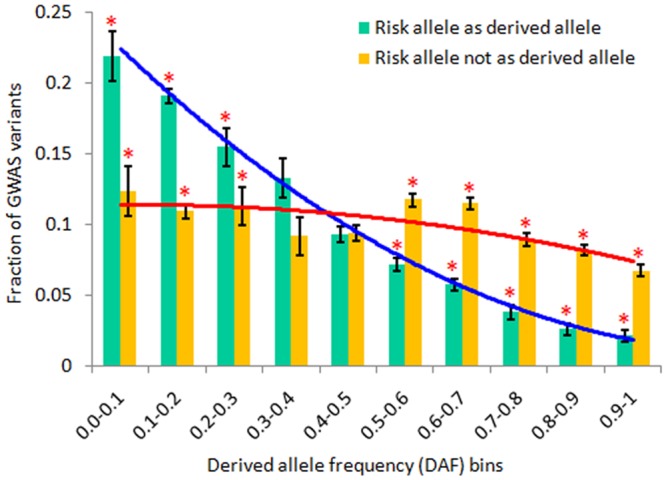
Distribution of GWAS variants for Derived allele frequency (DAF) inferred purifying selection in the human genome.Comparison of combined allele frequency across the worldwide populations in each DAF bin for derived allele as a risk allele (blue line) and as a non-risk allele (red line). Results showed that purifying selection maintains the risk allele at a lower frequency while non-risk allele’s frequency showed nearly similar pattern in all the DAF bins, which could be a consequence of genetic drift in the populations. The astral represents significant differences between both of the datasets in each DAF bins (Fisher exact tests, P< 0.05). The error bar represents standard deviation of combined dataset across the populations.